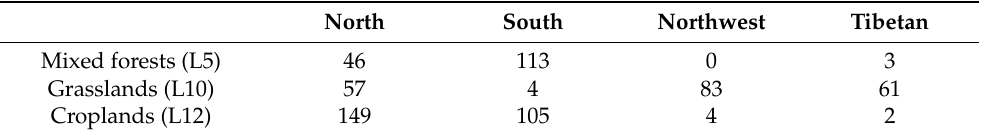
Table 3. The counts and percentages of observation stations at different regions of mixed forests, grassland, and cropland. North South Northwest Tibetan Mixed forests (L5) 46 113 0 3 Grasslands (L10) 57 4 83 61 Croplands (L12) 149 105 4